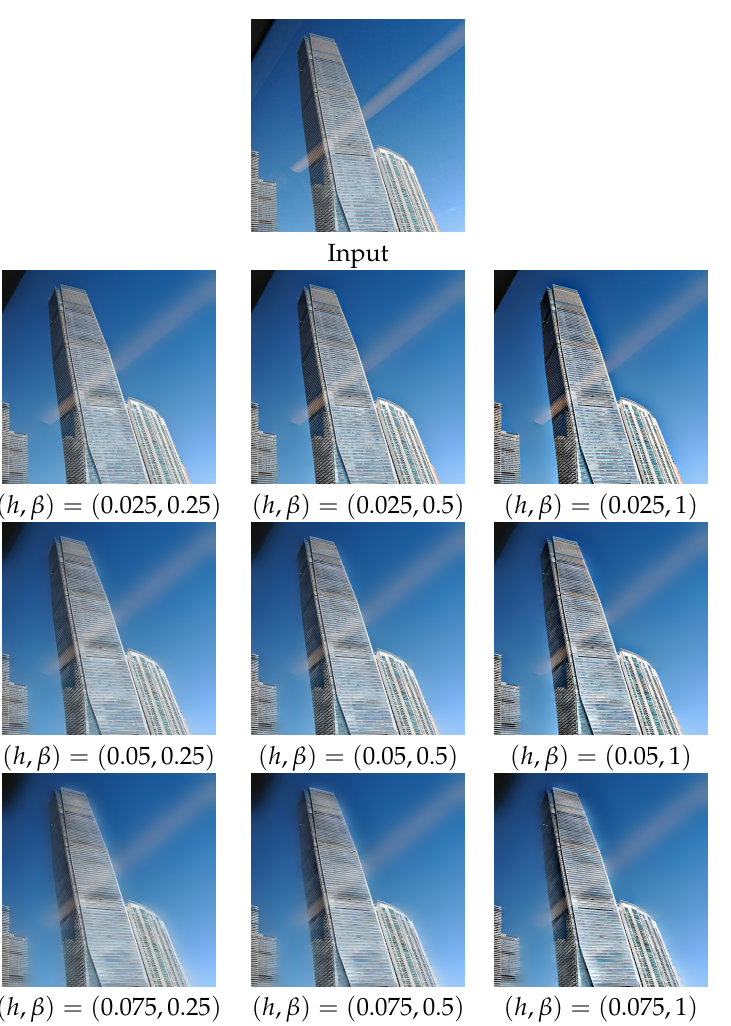
Figure 10. Reflection suppression results of the proposed algorithm (under N = 2 and ϕ in (12)) for real glass image ’Building’ with various h and β